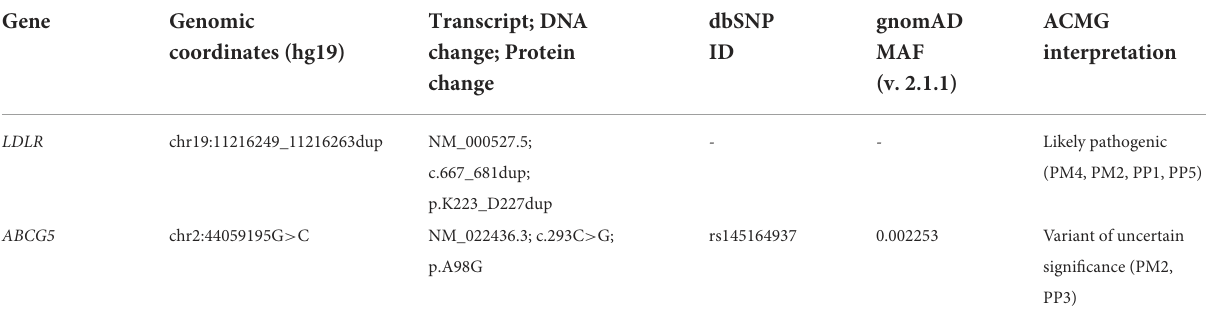
TABLE 1 Two Two rare variants with MAF < 0.01% identified in the